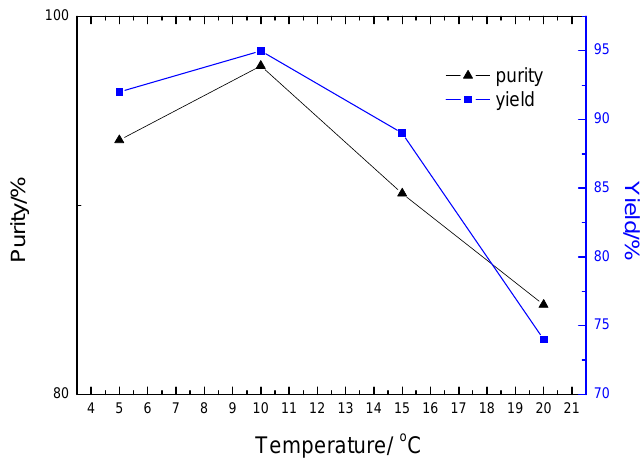
on purity and yield of DADNP. n